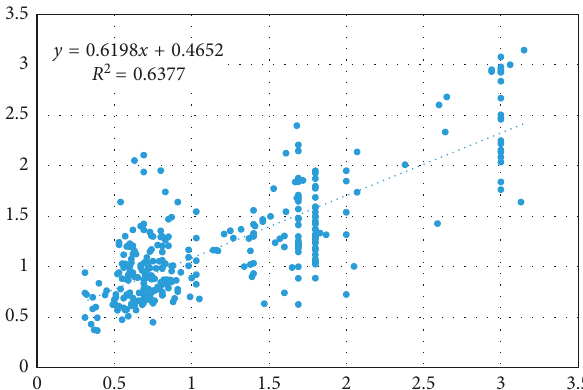
Figure 12: ANN training results for the prediction of the U-opaque in single-family and block buildings.